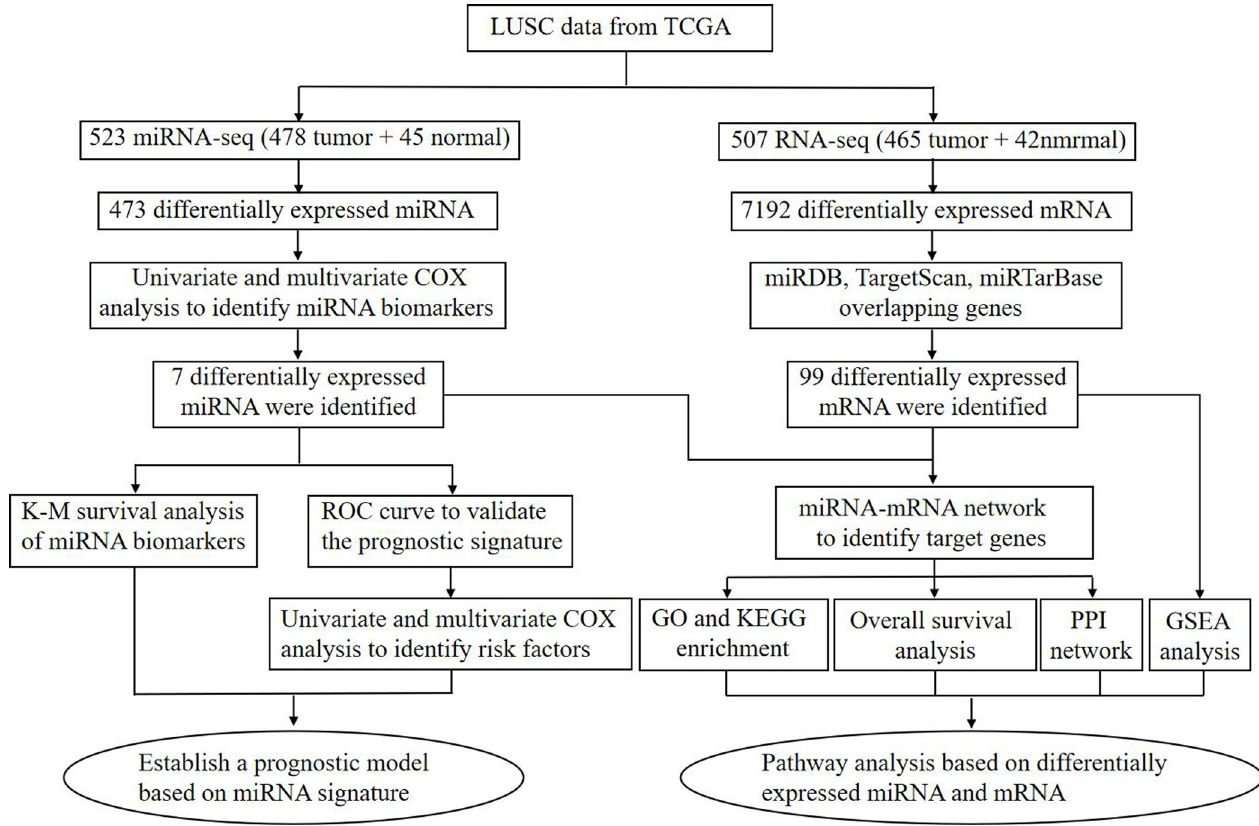
Fig 1. Flowchart of the bioinformatics analysis of LUSC data from TCGA databases.